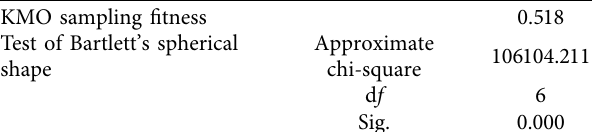
Table 2: KMO and Bartlett